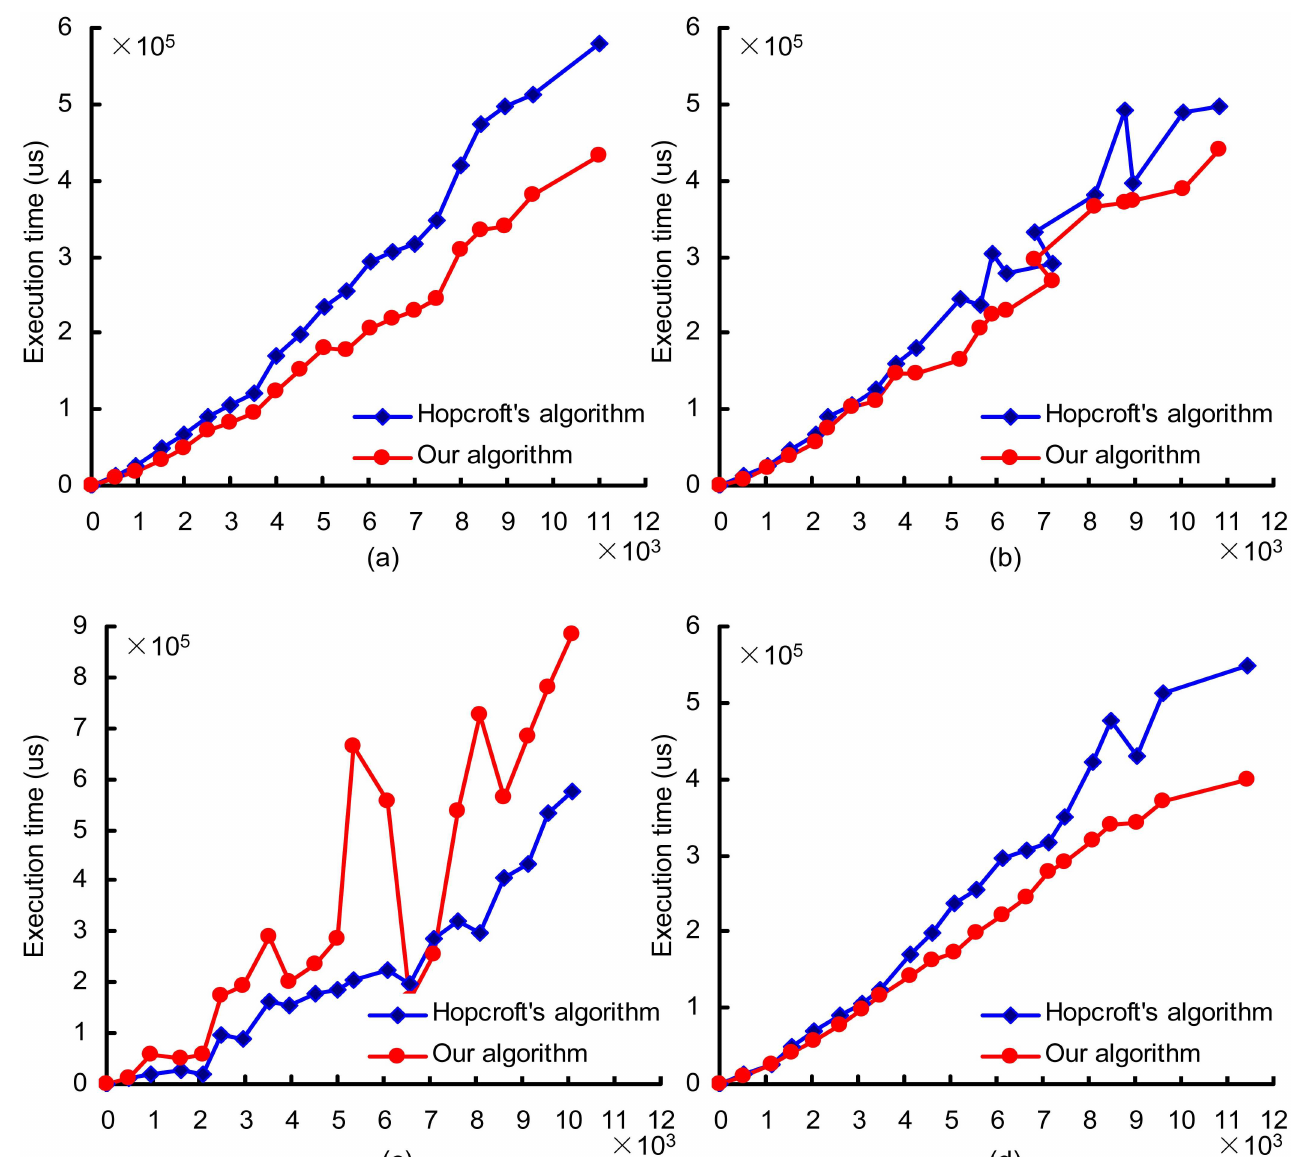
Fig 8. Experimental results for automata with different topological complexities. The horizontalaxis represents the number of states in the originalDFAs, and the vertical axis indicatesthe time consumed in microseconds.(a) DFA with an underlying graph consisting of a dictionary, (b) DFA with an underlying graph consisting of a tree, (c) DFA with 1% wildcardsand dot-star terms, and (d) DFA with 3% wildcardsand dot-star terms.